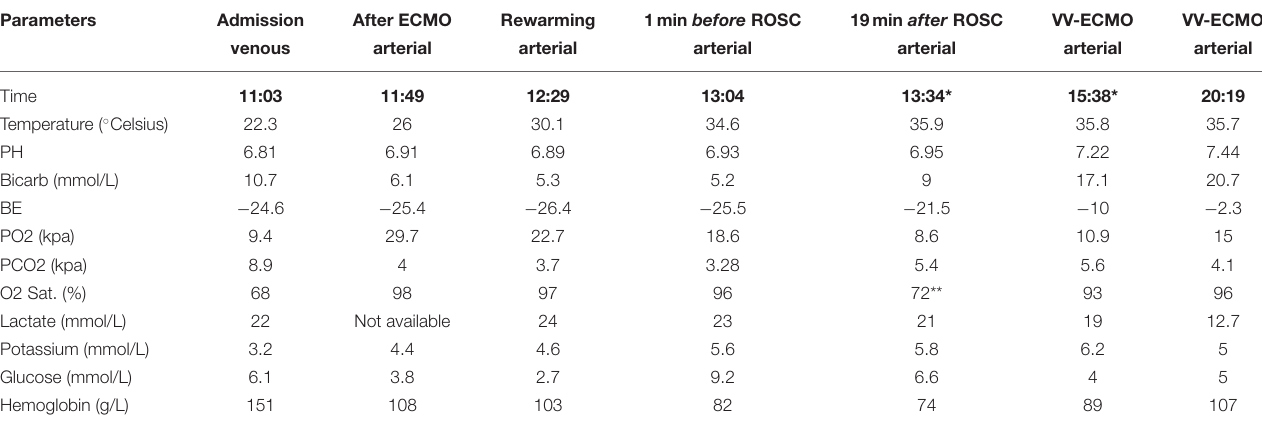
TABLE 1 | Timeline of sequential blood gas analysis.